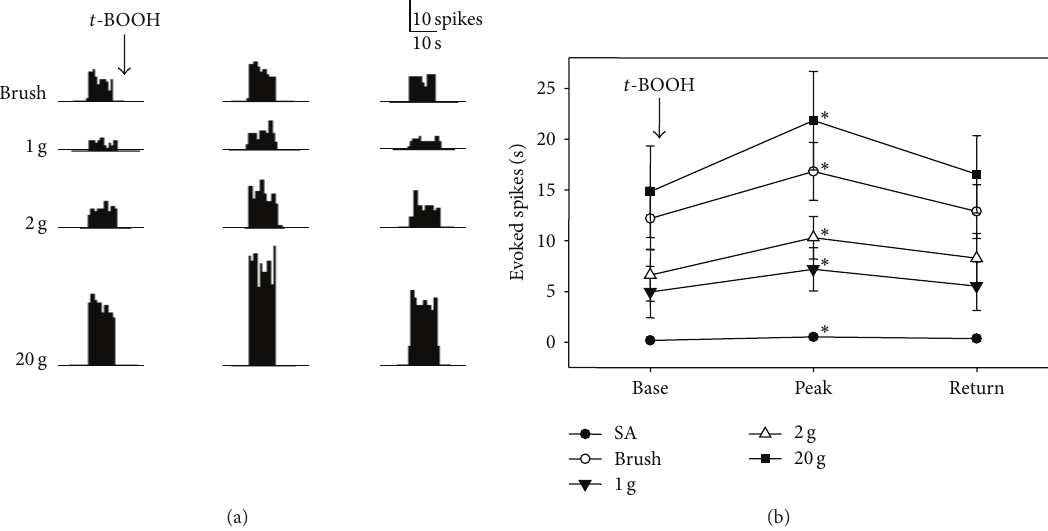
Figure 2: Effect of t -BOOH on WDR neuron activities in the spinal dorsal horn of normal rats. (a) The neurons responded well to a variety of mechanical stimuli applied to the receptive field before administration of t -BOOH (left column). After local application of 1 𝜇 mol of t -BOOH in 10 𝜇 L to the spinal cord without washout, the discharge rates started to increase, peaked by 60.0 ( ± 14.1) min (center column), and then returned to the baseline levels by 122.1 ( ± 32.1) min (right column). Stimulus duration is indicated by horizontal bars at the bottom. (b) Evoked responses of WDR neurons ( 𝑛 = 7 ) to various stimuli before and after t -BOOH application. Asterisks indicate values that are significantly different from the baseline values as determined by a one-way repeated-measures analysis of variance followed by the Duncan test ( 𝑃 < 0.05 ). The data are mean with standard errors of the